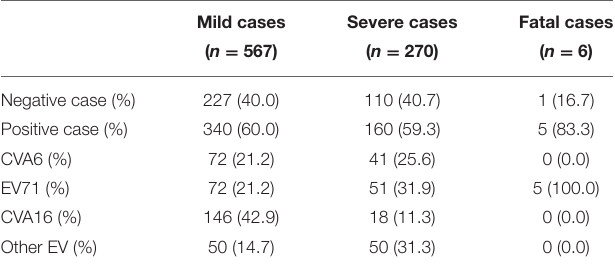
TABLE 2 | The total number of samples from mild cases, severe cases, and fatal cases tested in this